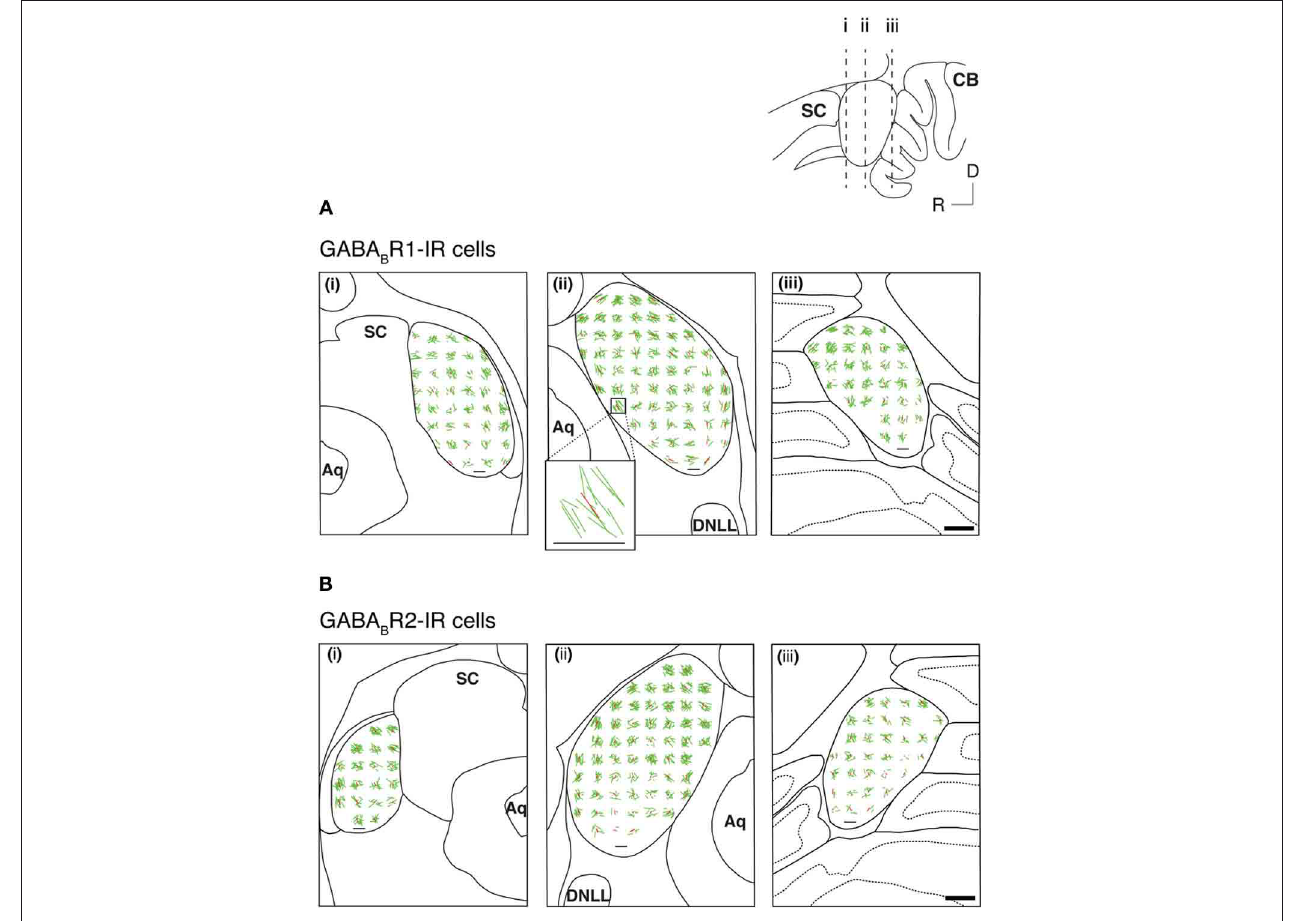
(EI) and the orientation indicating the orientation of the major axis of the neuron. Each red line indicates the mean of individual vectors in a grid box. Inset shows individual vectors and the mean vector in a grid box located at the ventromedial region of the IC in a section from the middle rostrocaudal level of the IC of the case shown in (A) . A small horizontal black line in the area of IC in each panel and the horizontal line at the bottom of the inset indicate an EI value of 1. Scale bar (thick horizontal line) in A(iii) and B(iii) : 500 μ